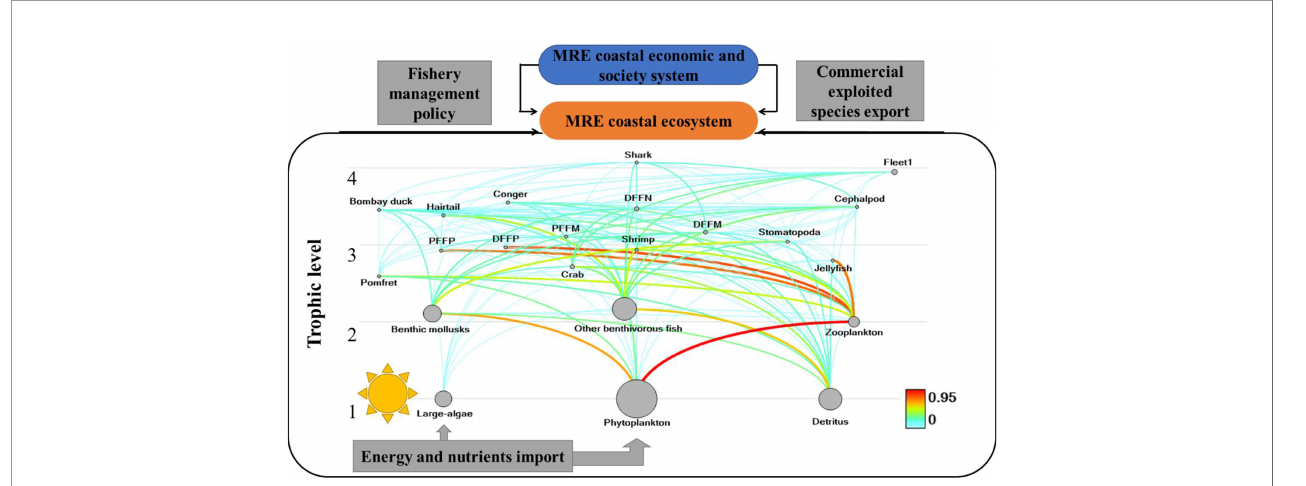
FIGURE 2 | Concept map of energy network of the Minjiang Estuary ecosystem. MRE, Minjiang estuary; PFFP, pelagic fi sh feeding on plankton; PFFM, pelagic fi sh feeding on mixed biophagy; DFFP, demersal fi sh feeding on plankton; DFFN, demersal fi sh feeding on nekton; DFFM, demersal fi sh feeding on mixed